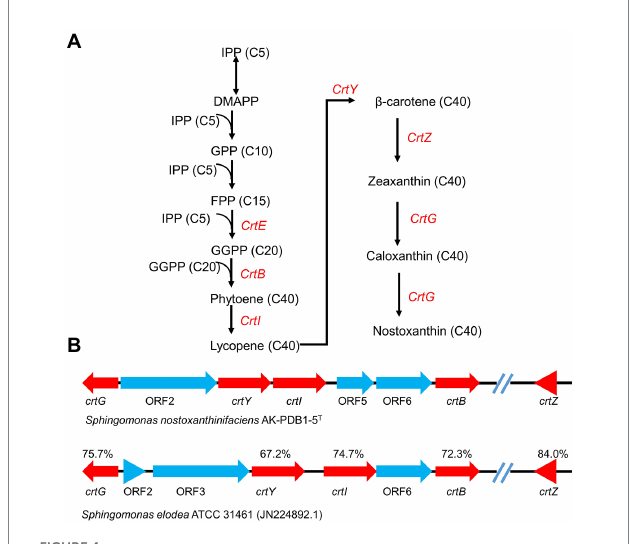
FIGURE 4 Carotenogenic gene clusters and the proposed biosynthetic pathway of nostoxanthin in strain AK-PDB1-5 T . (A) comparison of the gene cluster in strain AK-PDB1-5 T (up) and “Sphingomonas elodea” ATCC 31461 (JN224892.1; bottom). The genes are presented as arrows pointing in the direction of transcription; the value below each gene designates the similarity of nucleotides between the AK-PDB1-5 T nostoxanthin biosynthetic enzyme and the corresponding gene from the S. elodea ATCC 31461. (B) nostoxanthin biosynthetic pathway in strain AK-PDB1-5 T . IPP, isopentenyl pyrophosphate; DMAPP, dimethylallyl pyrophosphate; FPP, farnesyl diphosphate; GGPP, geranylgeranyl diphosphate. crtE , GGPP synthase; crtB , phytoene synthase; crtG, carotenoid 2,2- β -hydroxylase; crtI , phytoene desaturase/dehydrogenase; crtY , lycopene cyclase; crtZ ,